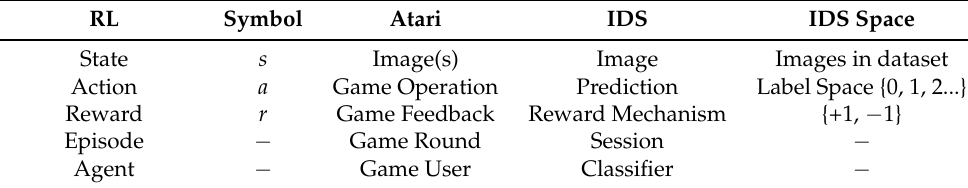
Table 3. Comparison between Atari game and the intrusion detection